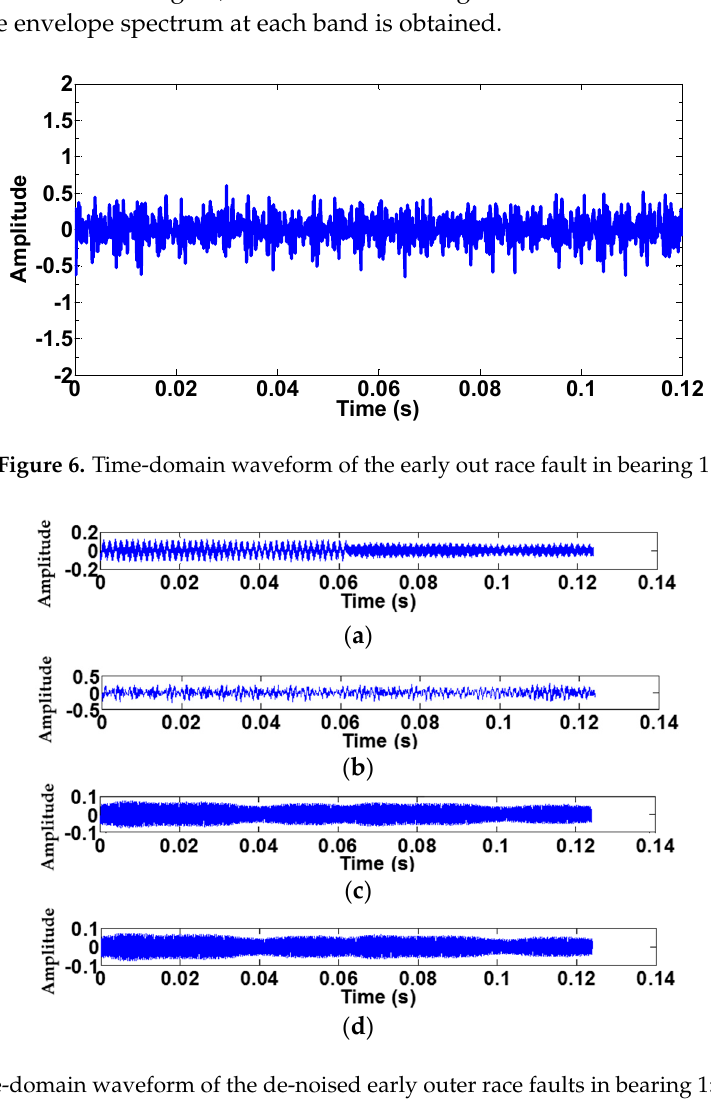
Figure 7. Time-domain waveform of the de-noised early outer race faults in bearing 1: ( a ) De-noised signal by MMBDSOICE; ( b ) De-noised signal by MMBCSOICE; ( c ) De-noised signal based on MPODSOISE; ( d ) De-noised signal based on